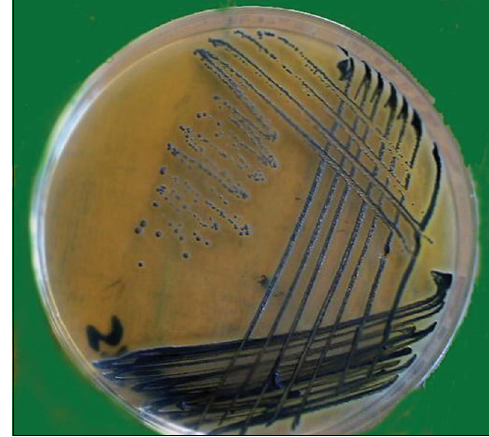
Figure-1: Staphylococcus aureus on Baired-Parker medium showed black, convex, shiny, colonies, and 1-1.5 mm in diameter surrounded by clear zone.